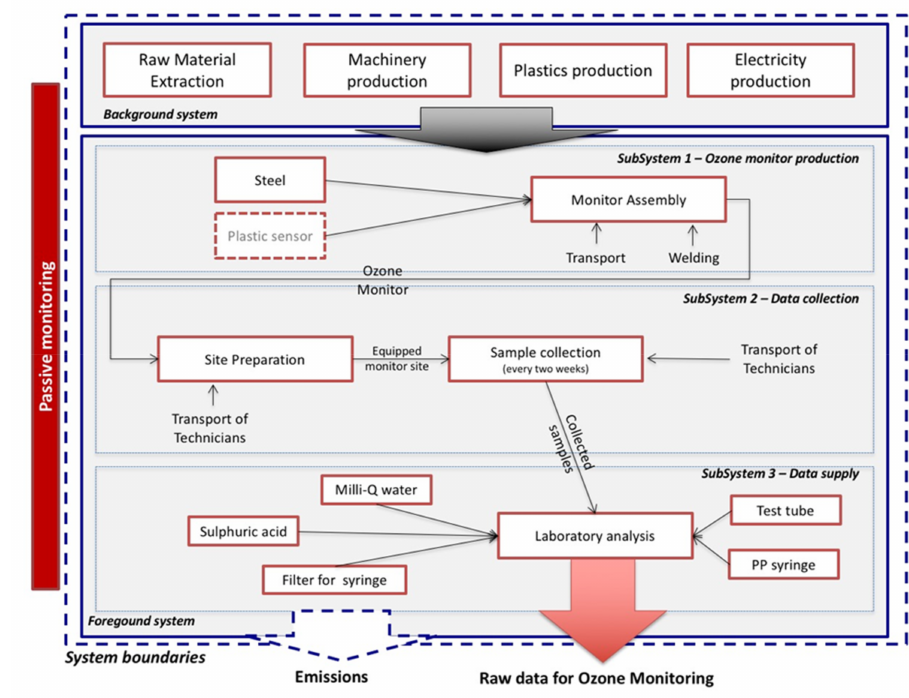
Figure 3. Flow chart and system boundaries for passive ozone monitoring in a